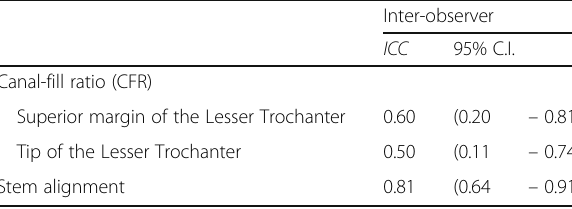
Table 1 Inter-observer reliability (intra-class